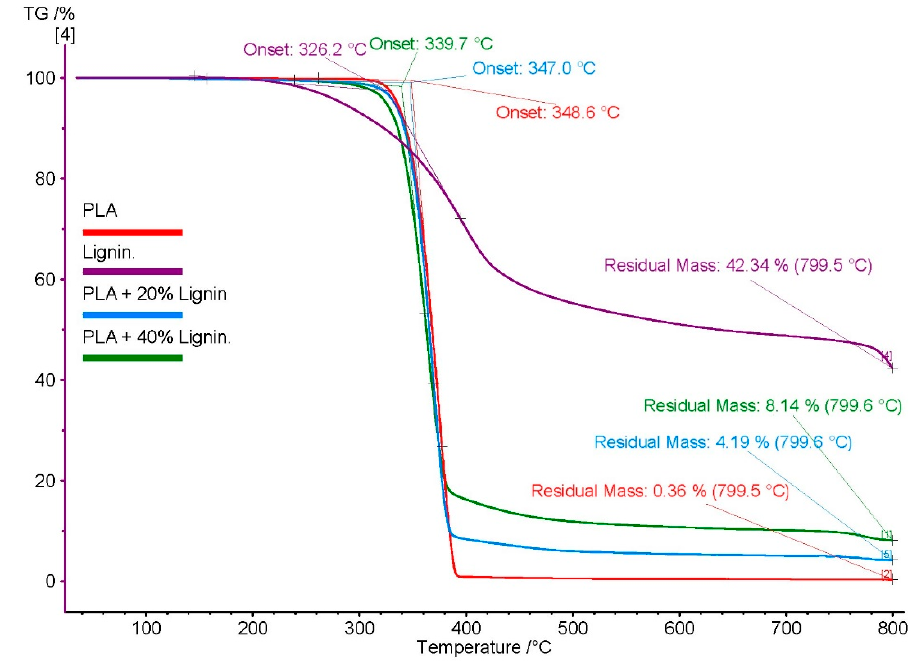
Figure 1. Thermo-gravimetric analysis (TGA) plot of Lignin, polylactic acid (PLA), and PLA/Lignin biocomposites .